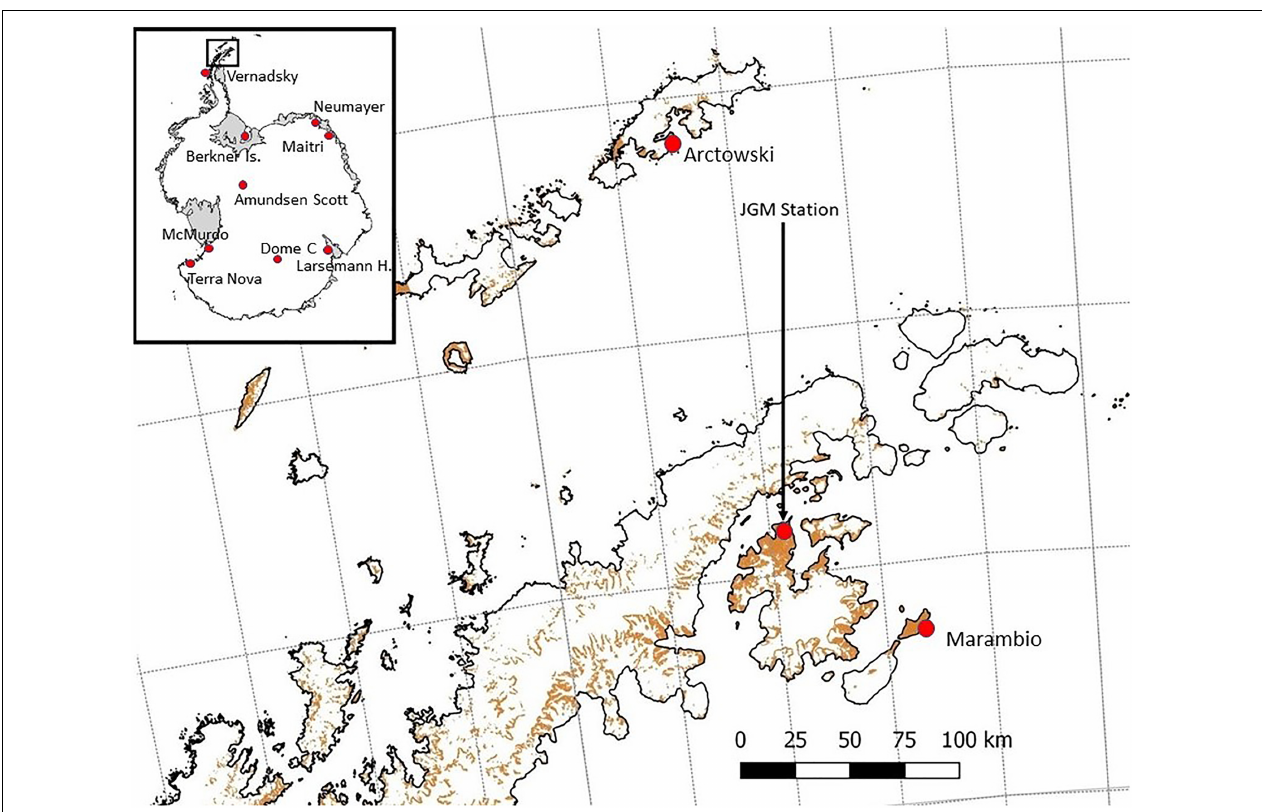
FIGURE 1 | Study site location (JGM Station) and other Antarctic sites used in the text, ice free areas in